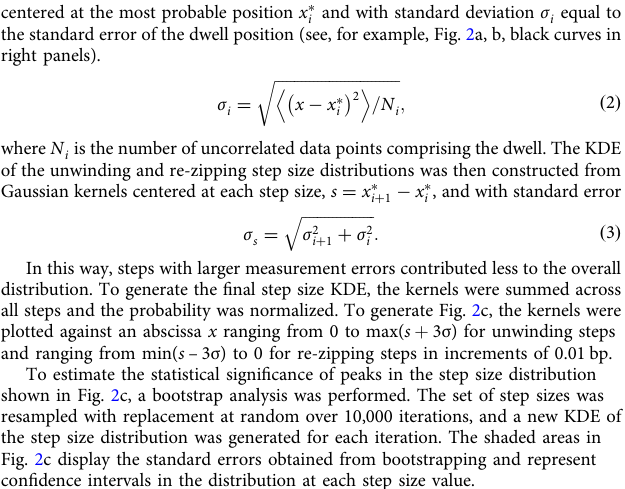
in position between two consecutive dwells. Step sizes for all traces at a given ATP concentration were combined to determine the step size distributions shown in Fig. 1g. Step sizes <0.5 bp were excluded from the data set. Number of steps, average step size, and step size standard errors at each ATP concentration for monomers are displayed in Supplementary Table 2, while the analogous values for dimer unwinding steps are displayed in Supplementary Table 3. In the second method, the position differences between every pair of data points were calculated for the same set of traces used in the fi rst method, keeping track